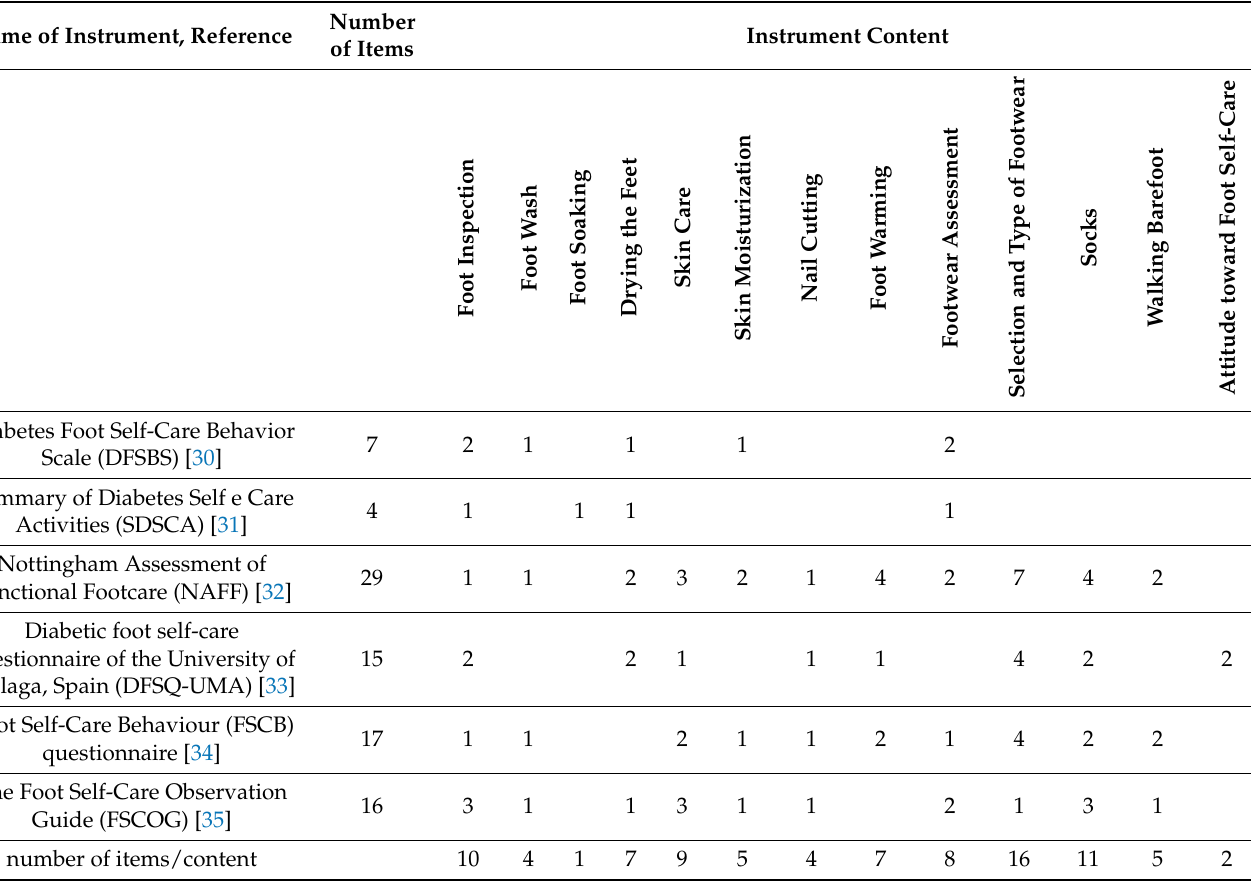
Table 1. Content and number of items in the instruments measuring foot